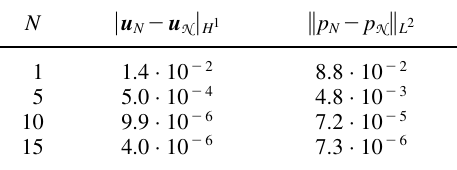
Table 2. The reduced basis error on a single bifurcation. N is the total number of degrees-of- freedom in the reduced basis spaces X 0